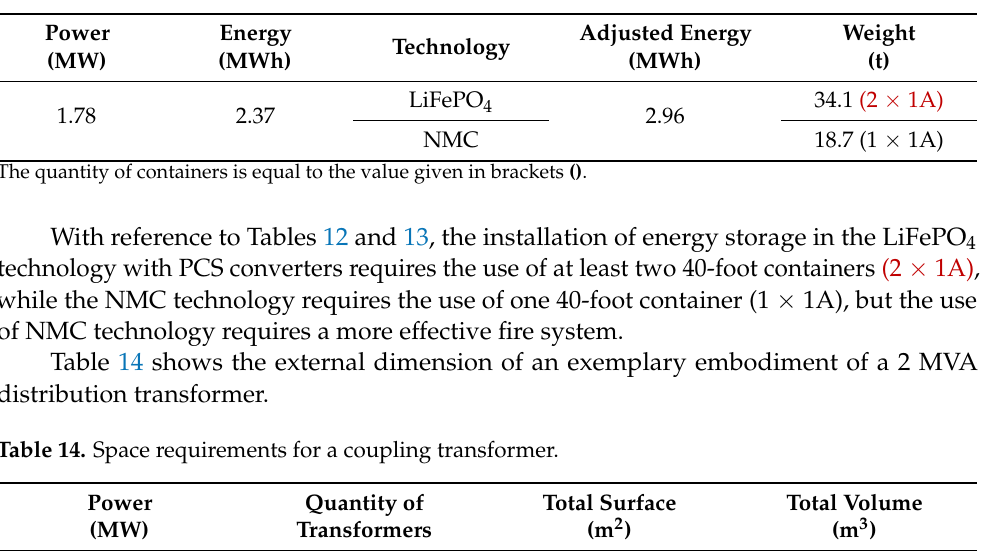
Table 13. Load-bearing requirement capacity of container structures.